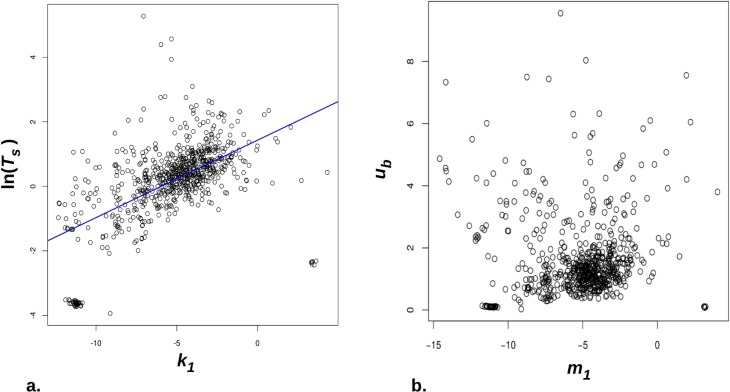
a. Correlation between kb and Ts in the population. ln(Ts) is plotted against kb, as the latter is already in ln units and the two enter Eq 2 on the same footing. Pearson r = 0.55, p < 1e-70. b. Similar plot for the KU parameterisation. r = -0.03, p = 0.37. Note two 'clumps' near ub ~ 0 (or ln(Ts) approx. -4 to -2) which appear separate from main cloud of points.